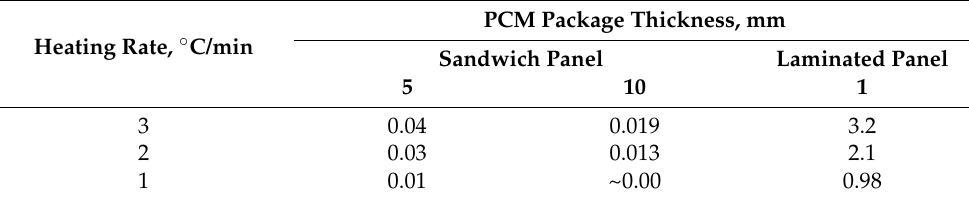
Table 1. Dependence of maximum deflection (mm) of the panel on the heating rate. PCM Package Thickness, mm Heating Rate, ◦ C/min Sandwich Panel Laminated Panel